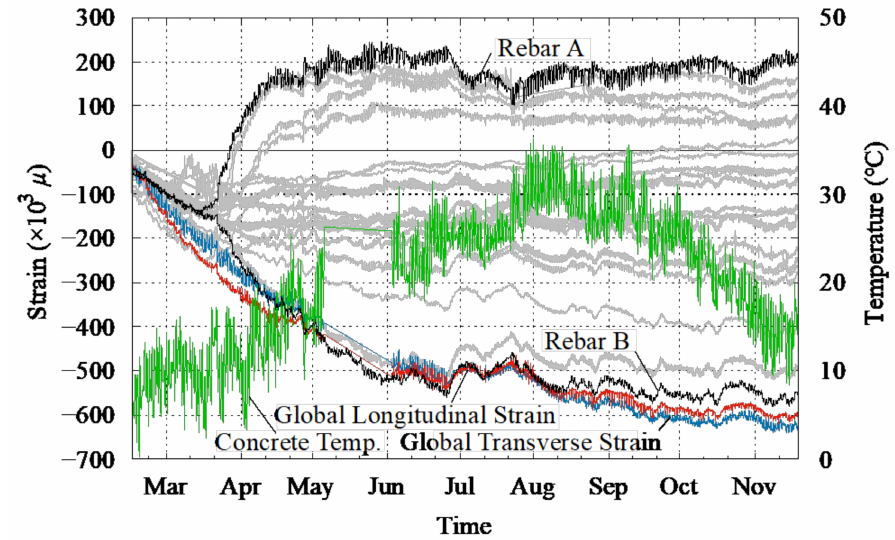
Figure 9. Shrinkage strain, rebar strain at the bottom interface, and temperature history during drying (* Location of Rebar A and B are shown in Figures 1 and